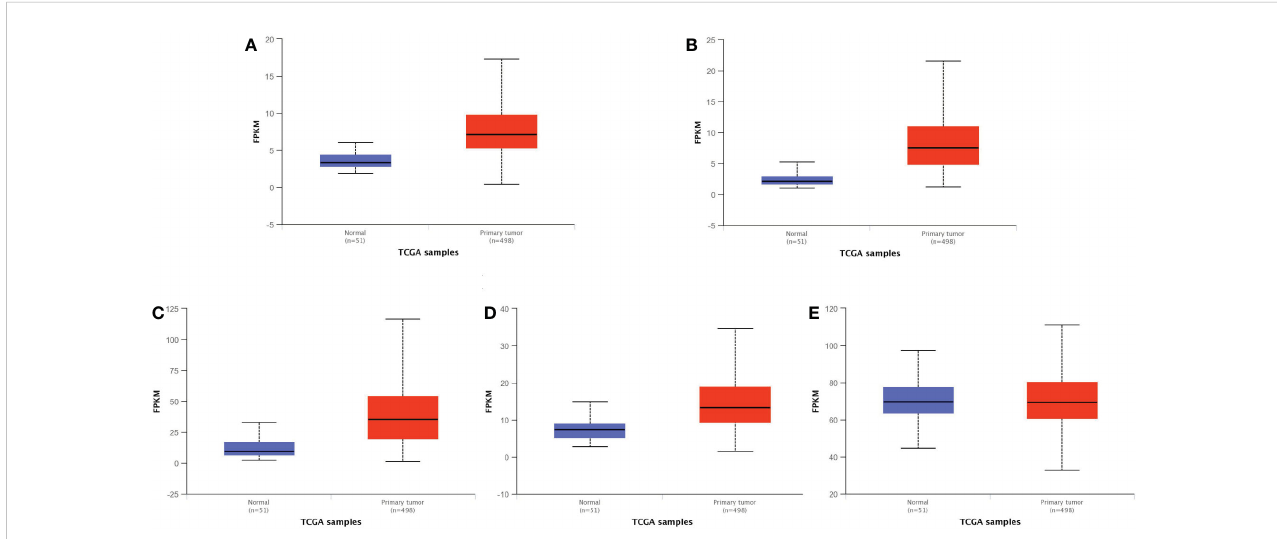
FIGURE 6 Expression levels of fi ve lncRNA in normal and primary tumor. (A) PCAT6; (B) SNHG3; (C) NEAT1; (D) SNHG7; (E) NORAD. Difference is extremely signi fi cant in (A – D) , p < 0.001. There is no difference between them in (E) The bule box plots represent genes expressed in normal, and the red box plots represent genes expressed in primary